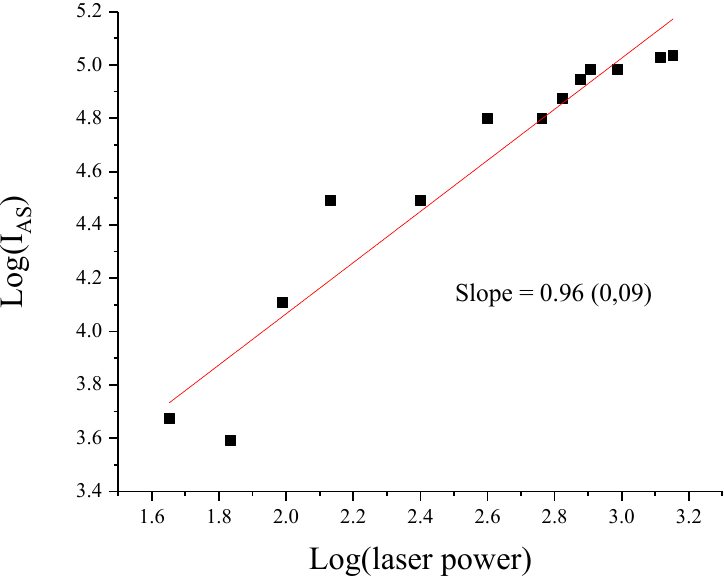
Figure 4. Linear log–log relationship between the anti-Stokes emission intensity and incident irradi- ance of the s -C 3 N 4 nanoparticles. The number in parentheses is the standard deviation. The log–log plot in Figure 4 indicates that in the case of s -C 3 N 4 nanoparticles we are dealing with the phonon-assisted anti-Stokes excitation process discussed in [10]. According to [10], a photon at the long-wavelength tail of the absorption spectrum excites an electron from a thermally populated first vibronic state of the electronic ground state to the bottom manifold of an excited electronic state. The system can then return to the ground state via spontaneous emission of an upconverted photon. This photon-assisted anti-Stokes excitation process scales exponentially with temperature [10]. The tentative schematic energy level diagram of the PL emission from s -C 3 N 4 is presented in Figure